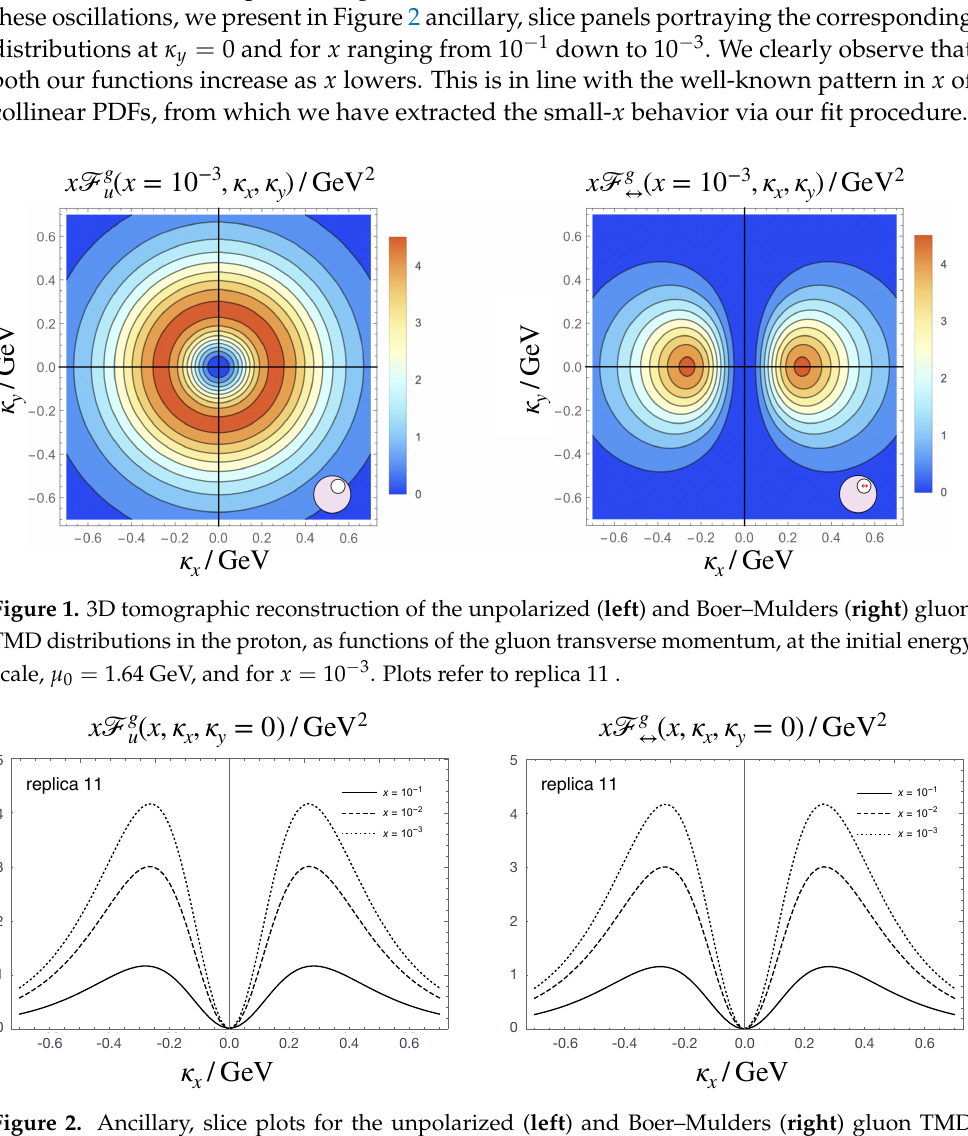
Figure 2. Ancillary, slice plots for the unpolarized ( left ) and Boer–Mulders ( right ) gluon TMD distributions in the proton, as functions of κ x , while κ y = 0, at the initial energy scale, µ 0 = 1.64 GeV, and for x ranging from 10 − 1 down to 10 − 3